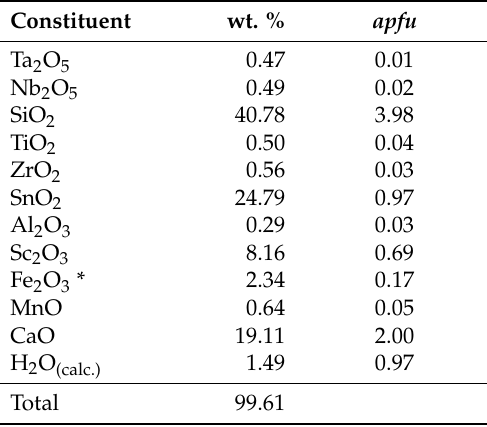
Table 1. Average electron-microprobe analysis of kristiansenite from Szklarska Por˛eba ( n = 4). Constituent wt. %